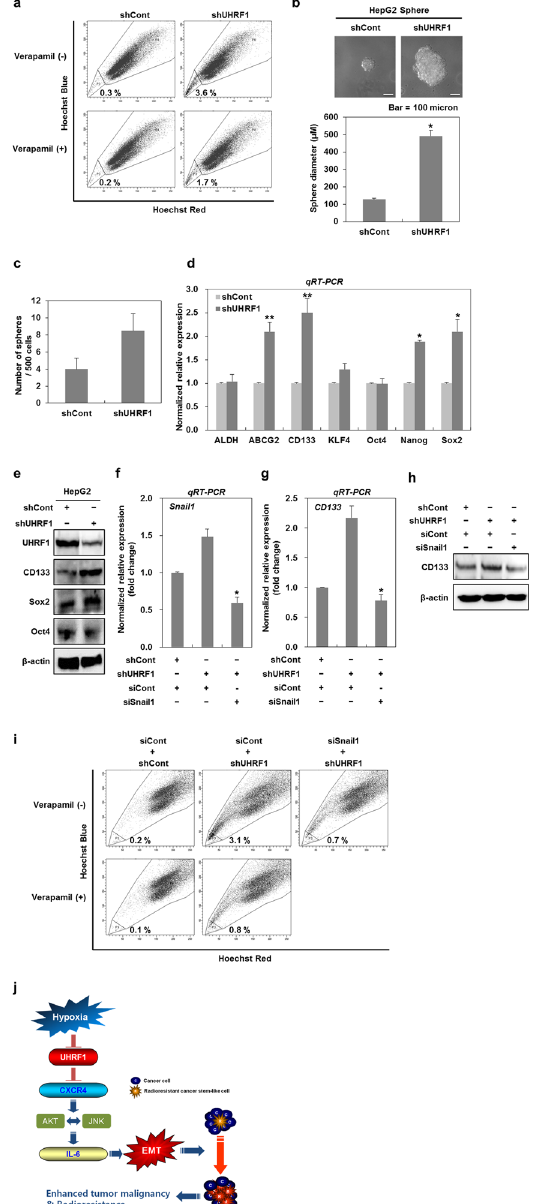
Figure 8. Downregulation of UHRF1 contributes to the expansion of cancer stem-like cells. ( a ) Flow cytometry analysis for the fraction of SP in shCont- and shUHRF1-HepG2 cells. shCont- and shUHRF1-HepG2 cells were stained with 5 μ g/ml of Hoechst 33342 in the presence or absence of verapamil (50 μ M), and the fraction of SP in the cells was analyzed using fluorescence-activated cell sorting. ( b and c ) Quantification of sphere-forming abilities of shCont- and shUHRF1-HepG2 cells. The cells were grown in DMEM/F12 supplemented with B27, N2, basic fibroblast- and epidermal growth factor onto 24-well ultra low attachment plates at 500 cells per well for 7 days, and the size and number of spheres were determined. To measure the size of sphere, 12 spheres per group were randomly selected. ( d ) qRT-PCR analysis for the mRNA expression levels of cancer stem cell-related factors in shCont- and shUHRF1-HepG2 cells. ( e ) Western blot analysis for CD133, Sox2 and Oct4 in shCont- and shUHRF1-HepG2 cells. ( f and g ) Effect of siRNA targeting Snail1 on the mRNA expression of CD133 in shUHRF1-HepG2 cells. The cells were grown in the presence or absence of siRNA targeting Snail1 for 48 h, and qRT-PCR analysis was performed. ( h ) Effect of siRNA targeting Snail1 on the protein expression level of CD133 in shUHRF1-HepG2 cells. The cells were grown in the presence or absence of siRNA targeting Snail1 for 48 h, and western blot analysis was performed. ( i ) Effect of siRNA targeting Snail1 on the fraction of SP in shURHF1 HepG2 cells. The cells were grown in the presence or absence of siRNA targeting Snail1 for 48 h, and the cells were stained with 5 μ g/ml of Hoechst 33342 in the presence or absence of verapamil (50 μ M). The fraction of SP in the cells was analyzed using fluorescence-activated cell sorting. ( j ) Schematic model underlying UHRF1 deficiency-induced EMT in hepatocellular carcinoma cells. β -actin was used as a loading control. Results from three independent experiments are expressed as means ± SEMs. ( * P < 0.05, ** P <